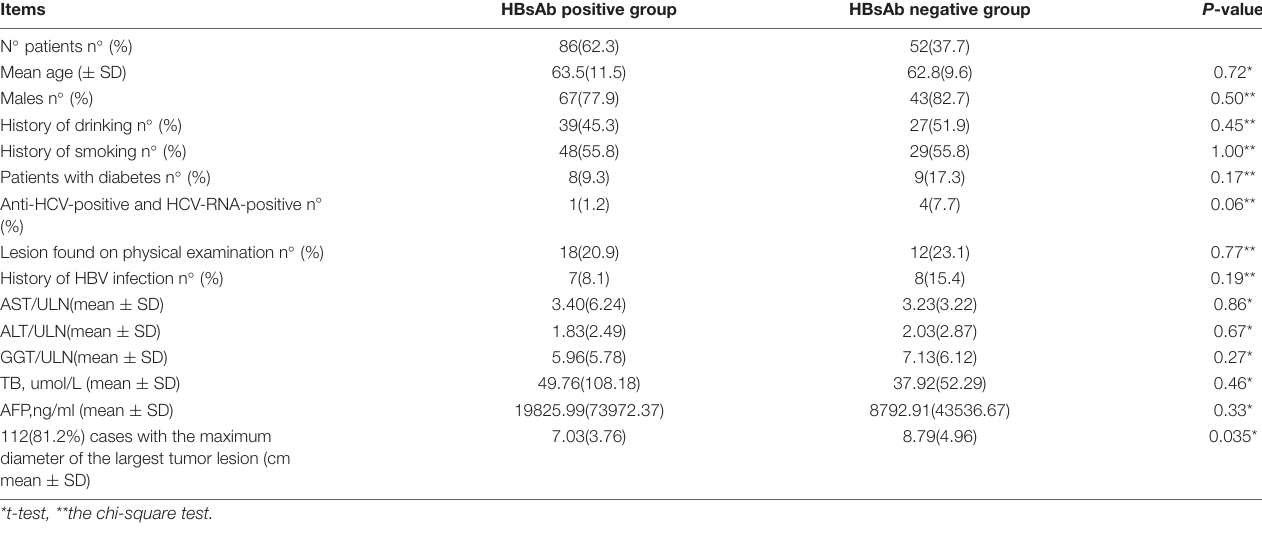
TABLE 3 | Comparison of baseline and HCC characteristics between the HBsAb Positive Group and the HBsAb Negative Group.